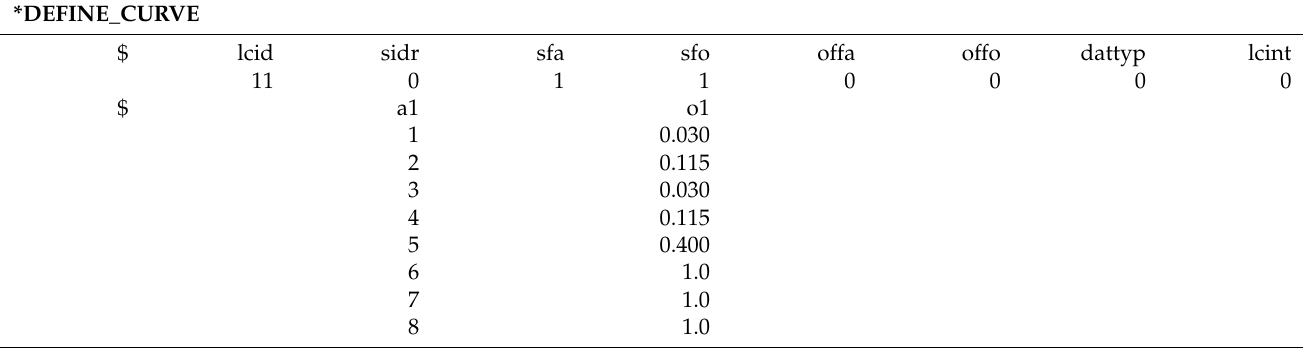
Table A3. Used failure strains.